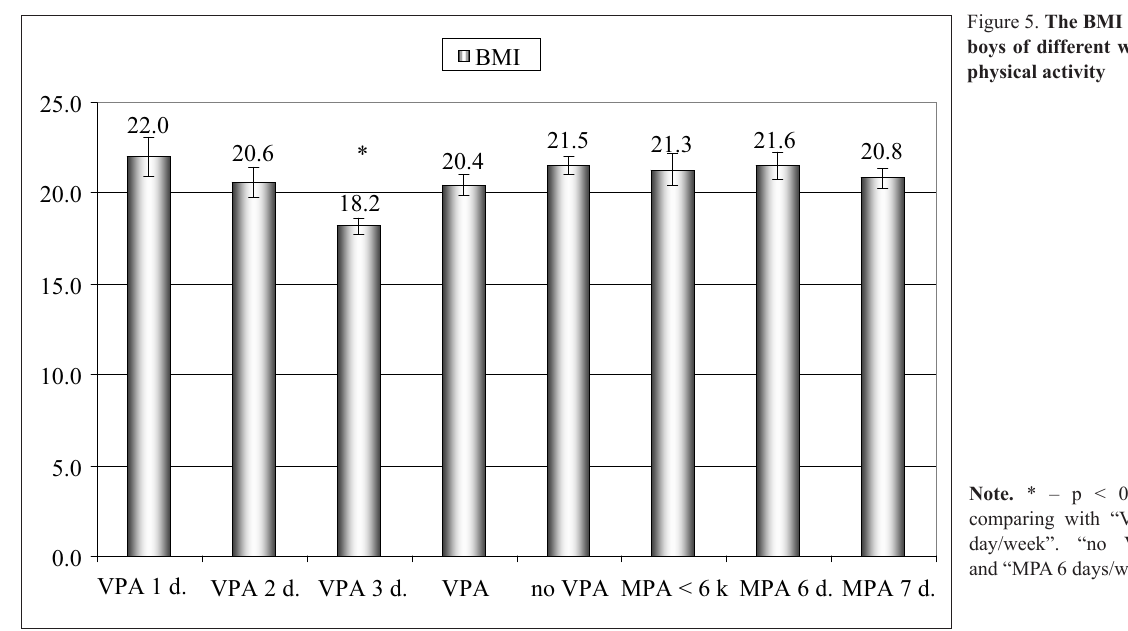
Figure 5. The BMI of the boys of different weekly physical activity